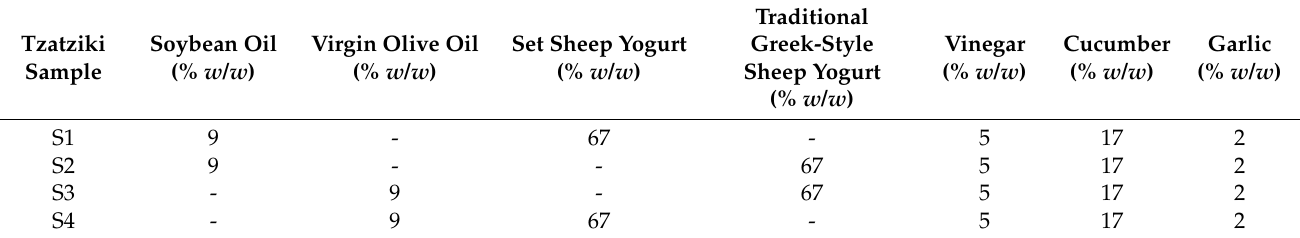
Table 1. Proportions used for the preparation of samples S1, S2, S3, and S4.